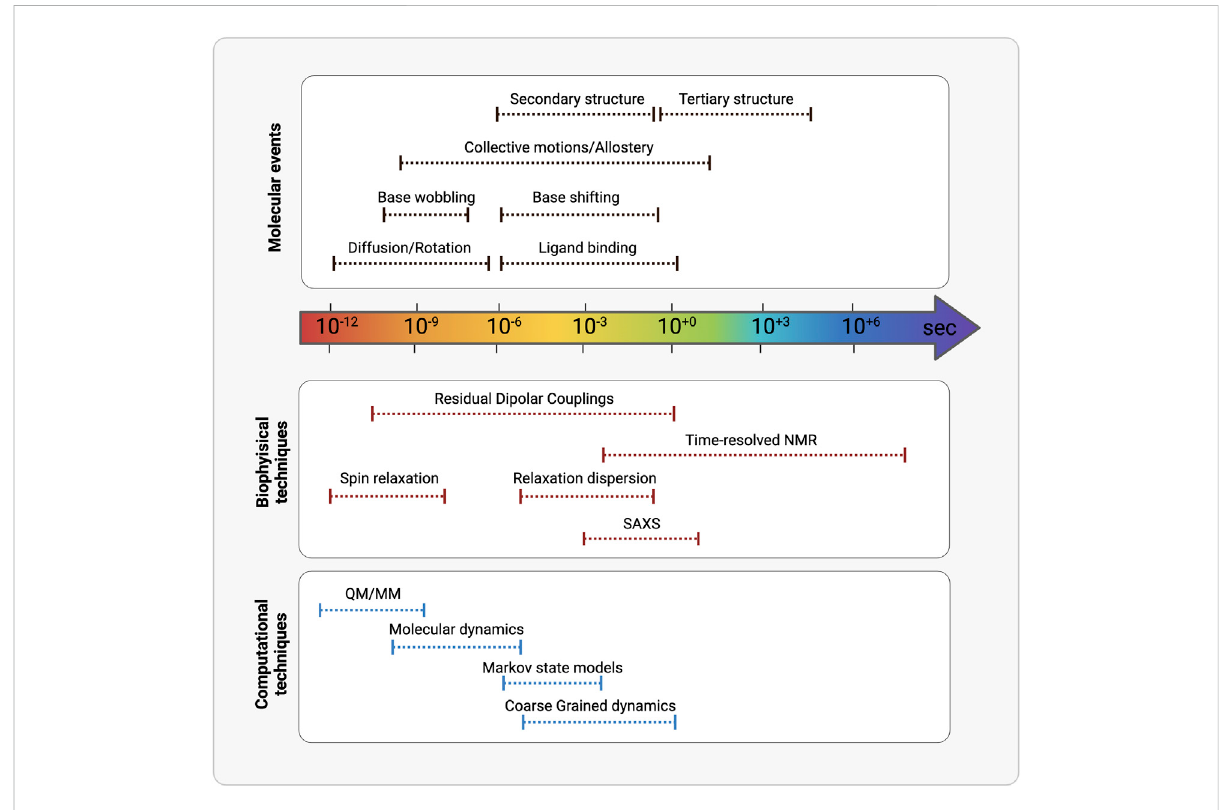
FIGURE 3 Schematic representation of the timescales overlaps between (from the top) molecular events, biophysical/analytical techniques and computational methodologies. (Realized with